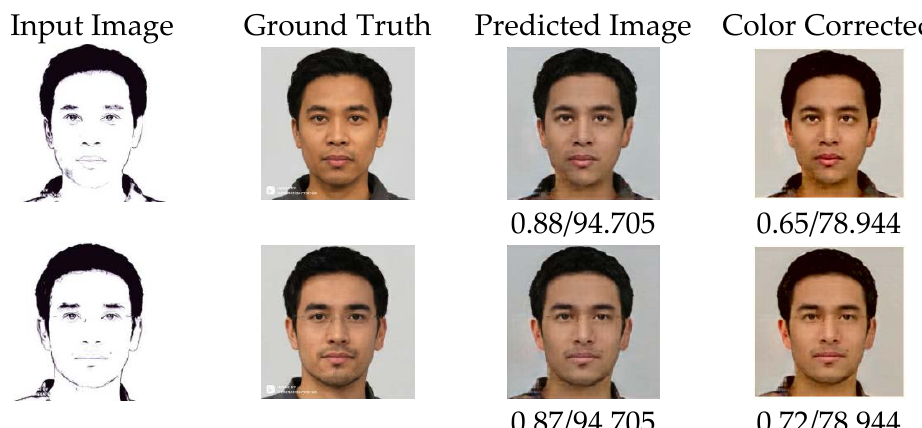
Figure 7. Results of fair configuration in correcting the color of predicted images. The values below the images represent SSIM/FID. The ground truth images are from generated photos [17].